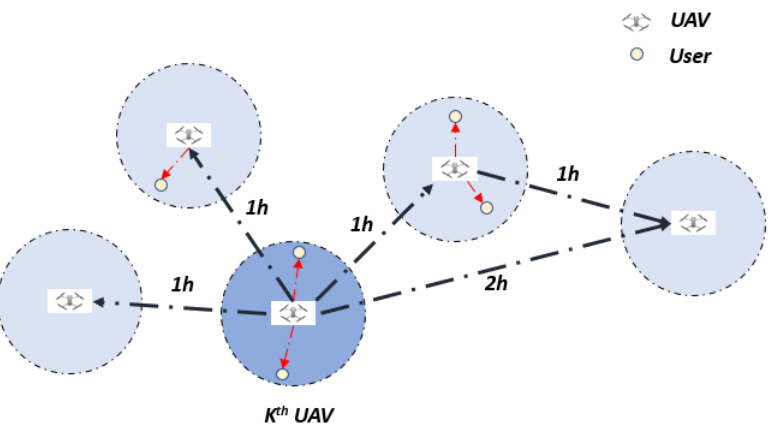
Figure 5. The figure shows five UAVs with blue-colored regions representing UAV’s ground coverage and five users represented by light yellow-colored dots. Red and black arrows show directions of P b and P u . K th UAV has two users within its U gr ( m k = 2): three one-hop ( n k = 3) and one two-hop ( n k (cid:48) = 1) neighbors. In this example, δ r = 0 and δ c =